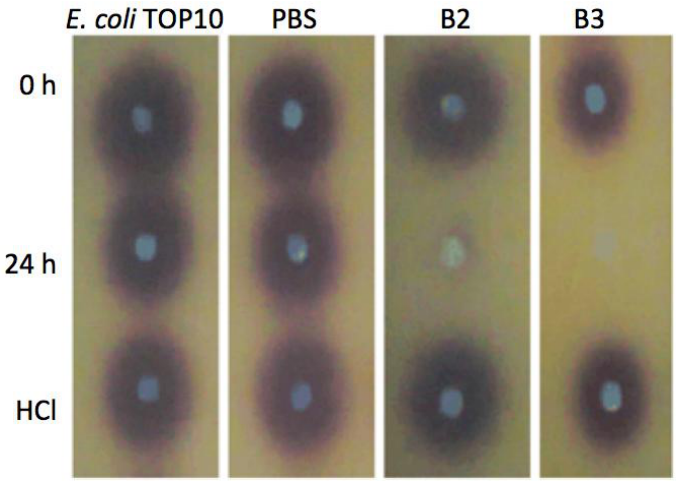
Figure 6. Detection of lactonase activity using CV026 overlay. Yeast suspensions (B2 and B3) were incubated with 3-oxo-C6-HSL for 0 h and 24 h as indicated on the left of figure. Positive QQ activity can be seen as the abolishment of purple pigments after 24 h of incubation. B. cereus represents the positive control while E. coli TOP10 and PBS buffer acted as negative controls. The purple pigments with the addition of hydrochloric acid (HCl) suggested re-lactonisation of the digested AHL indicated that both the isolates produced lactonase in the presence of